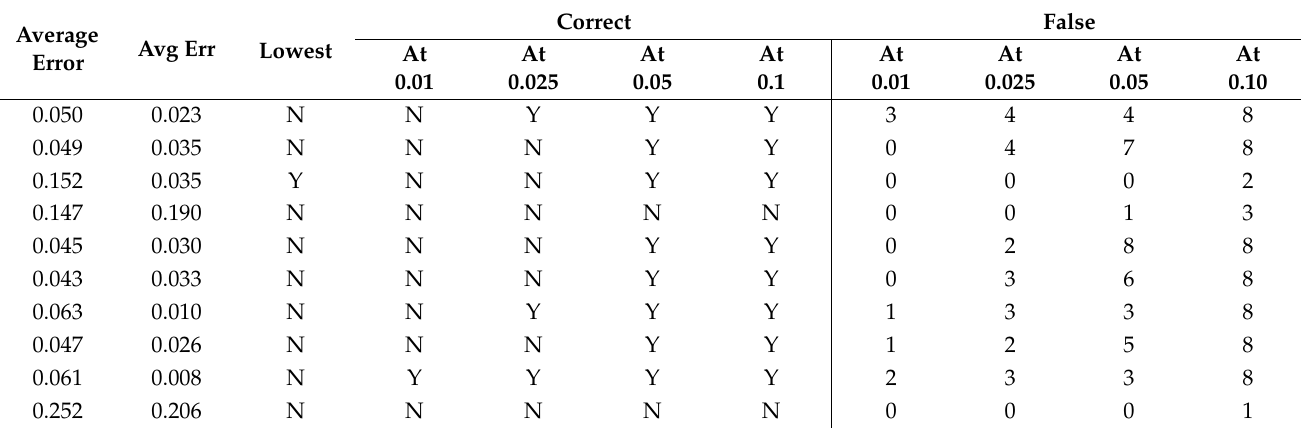
Table A78. Set 1, trials 41–50 summary data (average actual PR values).